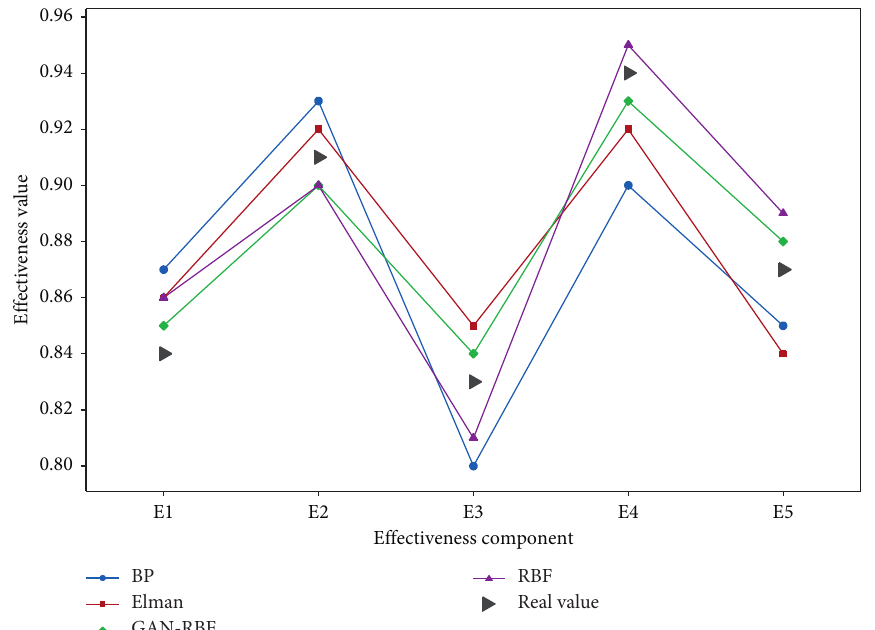
Figure 5: Comparison of the predicted value of four models’ effectiveness components and real